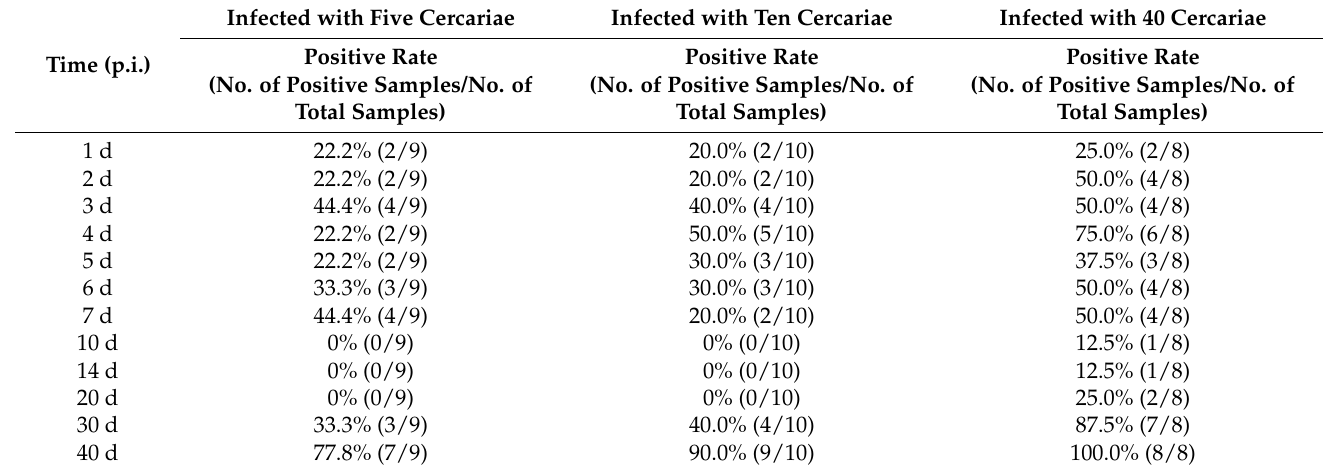
Table 1. Detection efficacy of the qPCR assay for mouse schistosomiasis japonica at different stages.